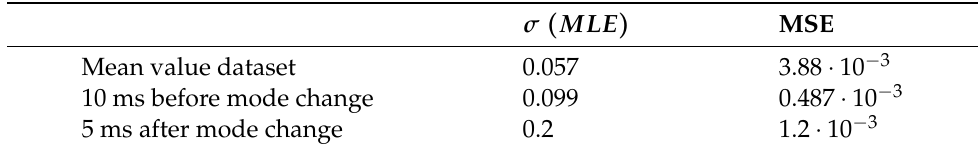
Table 1. Exemplary comparison of MSE to MLE in the area of a change in the mode of the automation for a single observation